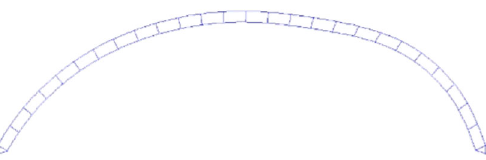
Figure 26. Global deformation during connecting plate failure.